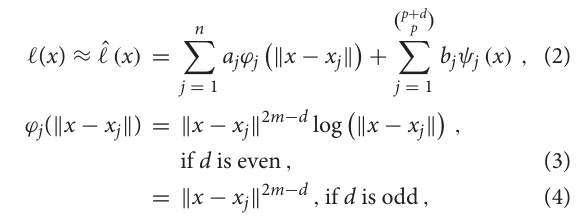
1977; Broomhead and Lowe, 1988; Buhmann, 2003;